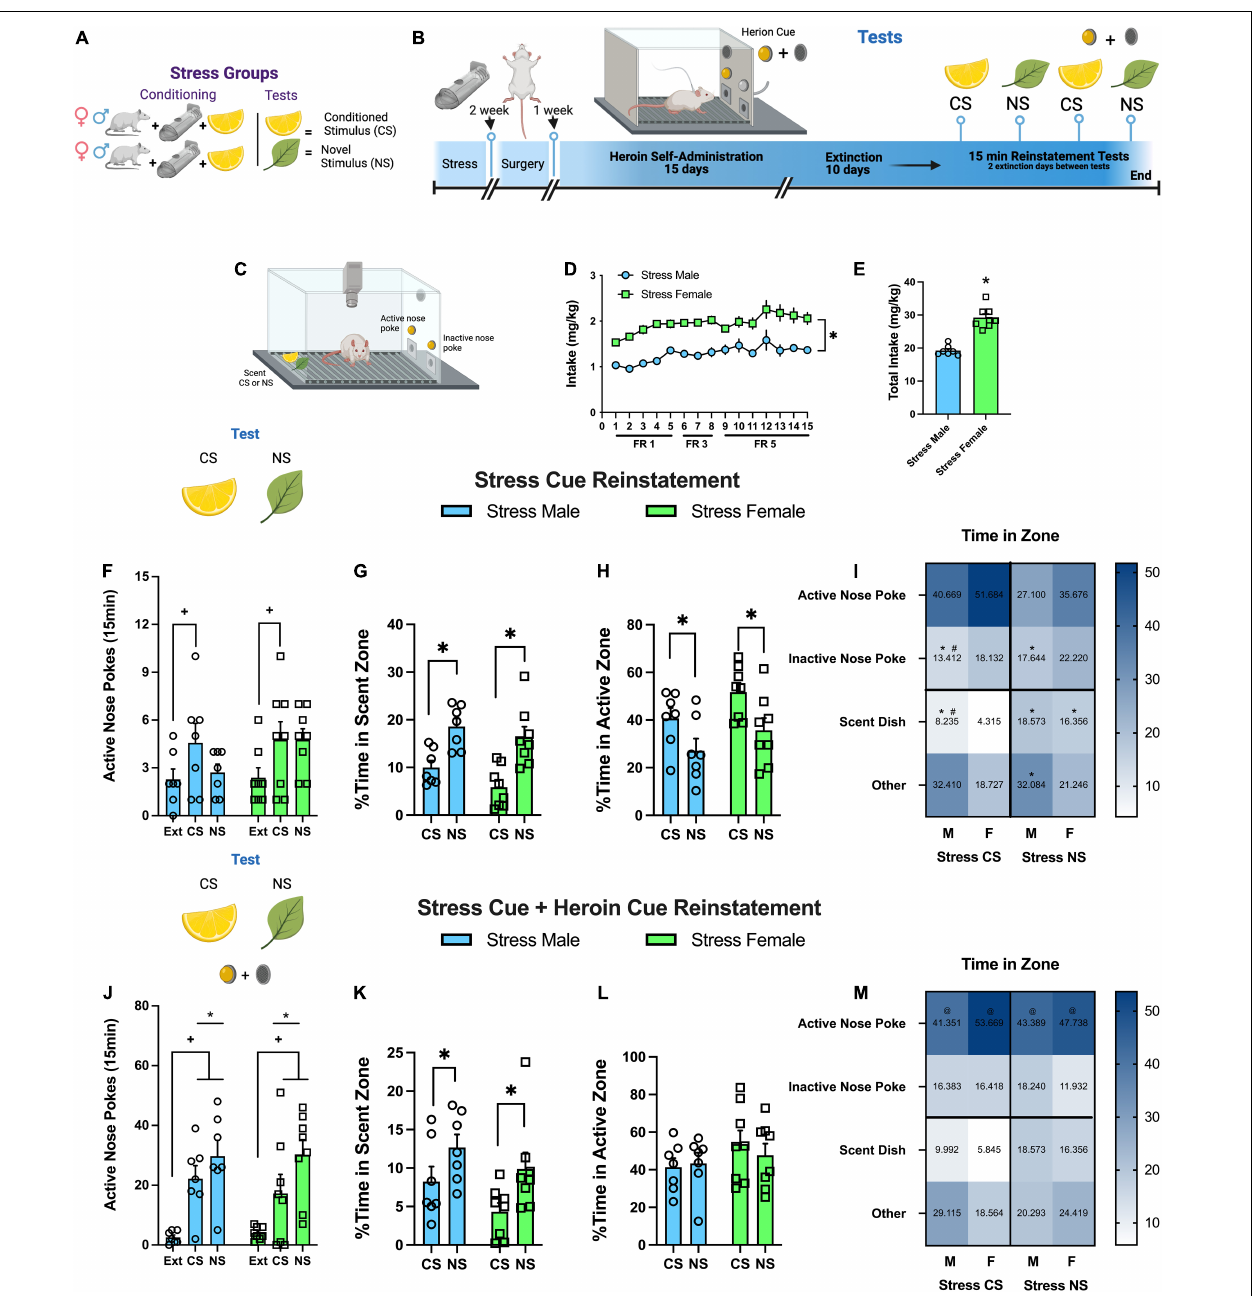
FIGURE 2 | Experiment 2: behavioral patterns in response to a stress conditioned stimulus during reinstatement testing. (A) Visual depiction of stress group and their relationship with the odor stimuli. (B) Experiment 2 timeline. (C) Visual depiction of operant self-administration chamber. (D) Heroin intake (mg/kg) over 15 self-administration sessions. Intake increased over the sessions, and females had greater intake than males. (E) Total heroin intake over 15 sessions; females took more heroin than males. (F) Active nose pokes during 15 min stress CS reinstatement tests. Both males and females increased active nose pokes in response to the stress CS. (G) %Time in scent zone during stress CS reinstatement tests. Rats spent less time in the scent zone when the stress CS was present. (H) %Time in active zone during stress CS reinstatement tests. Rats spent more time in this zone when the stress CS was present relative to the NS. (I) Heat-map of %time spent in the four different zones during stress CS tests. Time in zone interacted with the stimulus (CS or NS) and sex. Cell data is the group mean for comparison purposes (J) Active nose pokes during 15 min stress CS + heroin cue reinstatement tests. During stress CS + heroin cue test, rats elevated active nose pokes in response to the CS and NS relative to extinction. (K) %Time in scent zone during stress CS + heroin cue reinstatement tests. Rats spent less time in the scent zone when the stress CS was present. (L) %Time in active zone during stress CS + heroin cue reinstatement tests. There was no difference in time spent in the active zone between CS and NS. (M) Heat-maps of %time spent in the four different zones during stress CS + heroin cue tests. All groups spent more time in the active zone relative to the inactive nose poke, stress CS, and other. Cell data is the group mean for comparison purposes. Data are represented as group means ± SEM with individual values. * indicates significant difference from CS, p < 0.05. + indicates significant difference from extinction, p < 0.05. # indicates significant sex difference, p < 0.05. @ indicates significant difference from all other zones, p < 0.05.